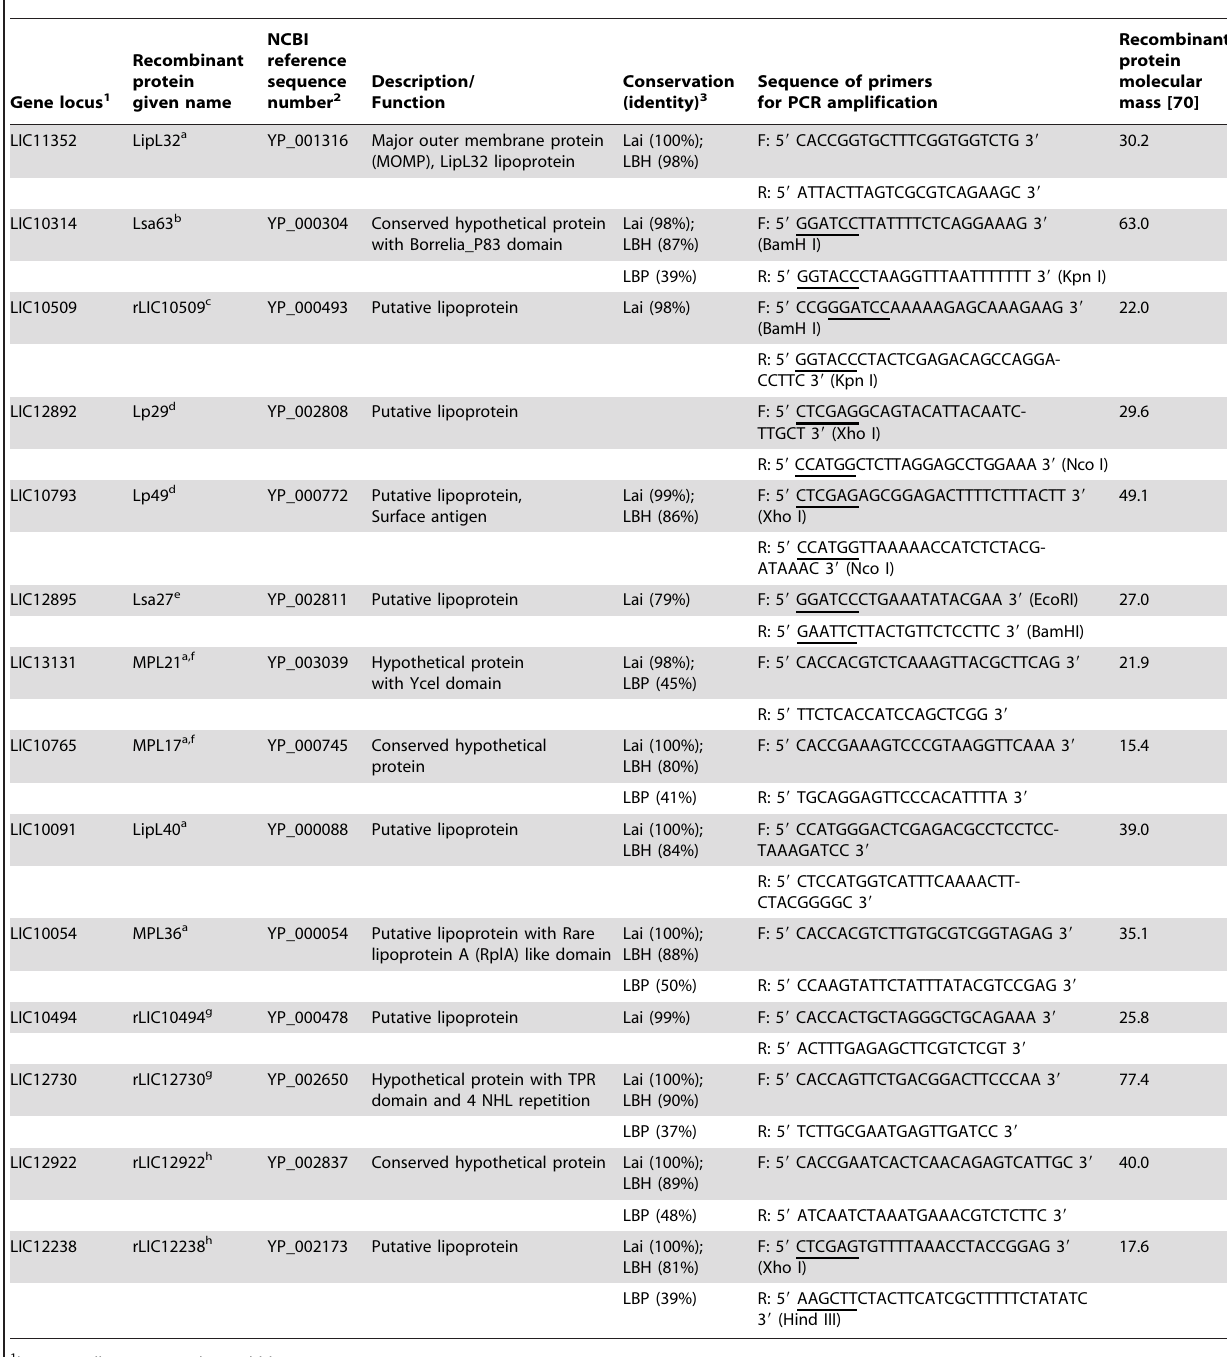
Table 1. Gene locus, protein name, NCBI reference sequence, features, gene conservation, sequence of the primers employed for DNA amplification, and molecular mass of expressed recombinant